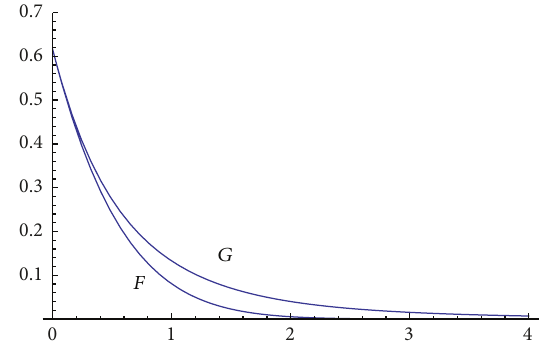
Figure 1: Graphs of 𝐹 5/2 (ℎ) and 𝐺 5/2 (ℎ) for ℎ ∈ [0,4] .